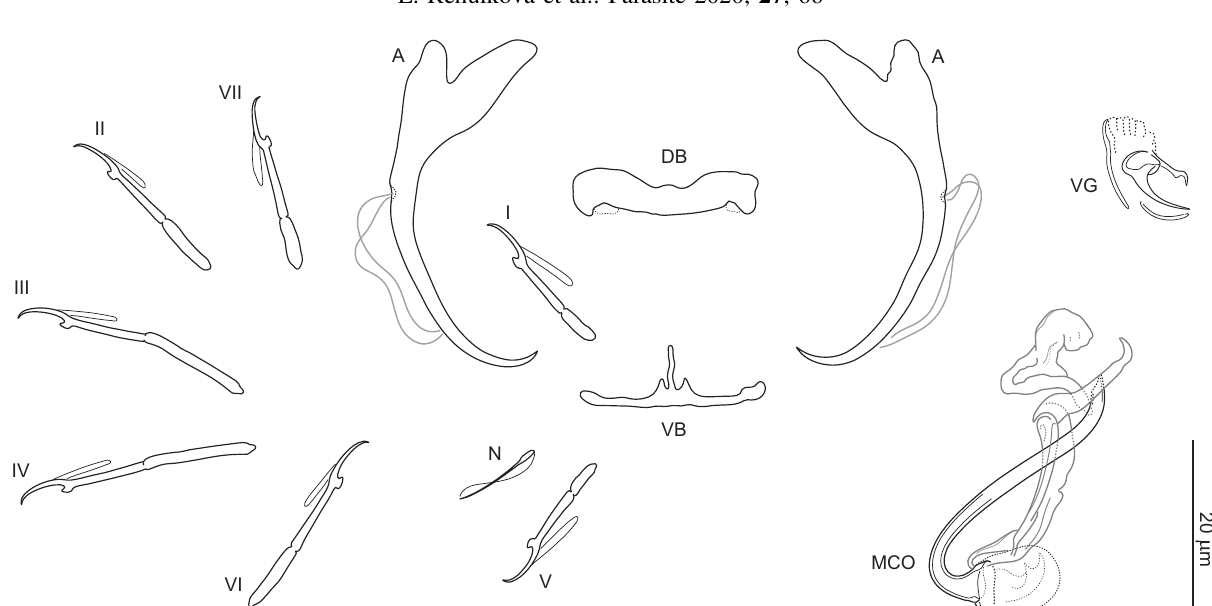
Figure 11. Sclerotized structures of Dactylogyrus vukicae n. sp. ex Delminichthys adspersus . A, anchor; DB, dorsal bar; VB, ventral bar; N, needle; I – VII, hooks; VG, vagina; MCO, male copulatory